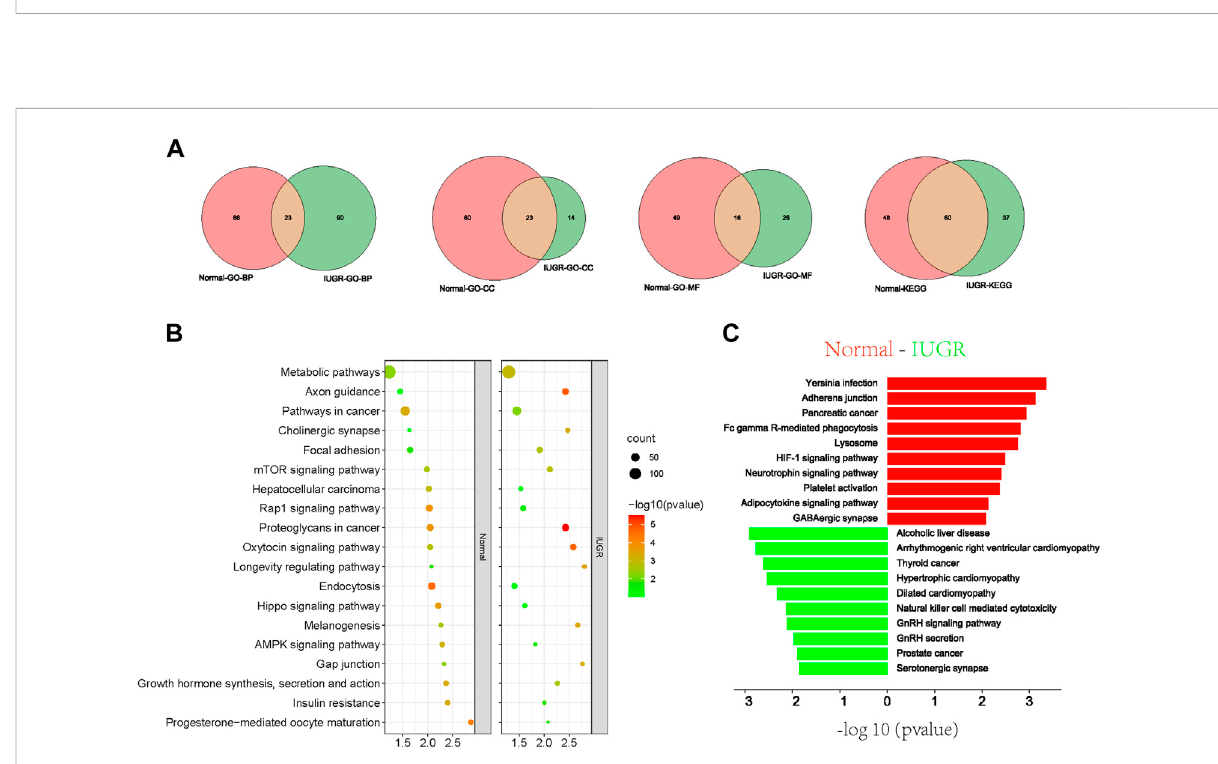
Gene Ontology (GO) and Kyoto Encyclopedia of Genes and Genomes (KEGG) pathway enrichment analyses of target genes of differential tRNA-derived small (tsRNAs). (A) Venn diagram of signaling pathways of differentially expressed tsRNAs in intrauterine growth restriction (IUGR) and normal-sizepigsannotatedagainstdifferentGOandKEGGentries. (B,C) KEGGanalysisofdifferentiallyexpressedtsRNAstargetgenes,togetherwith (B) signi fi cantly enriched signaling pathways and (C) individually signi fi cantly enriched signaling